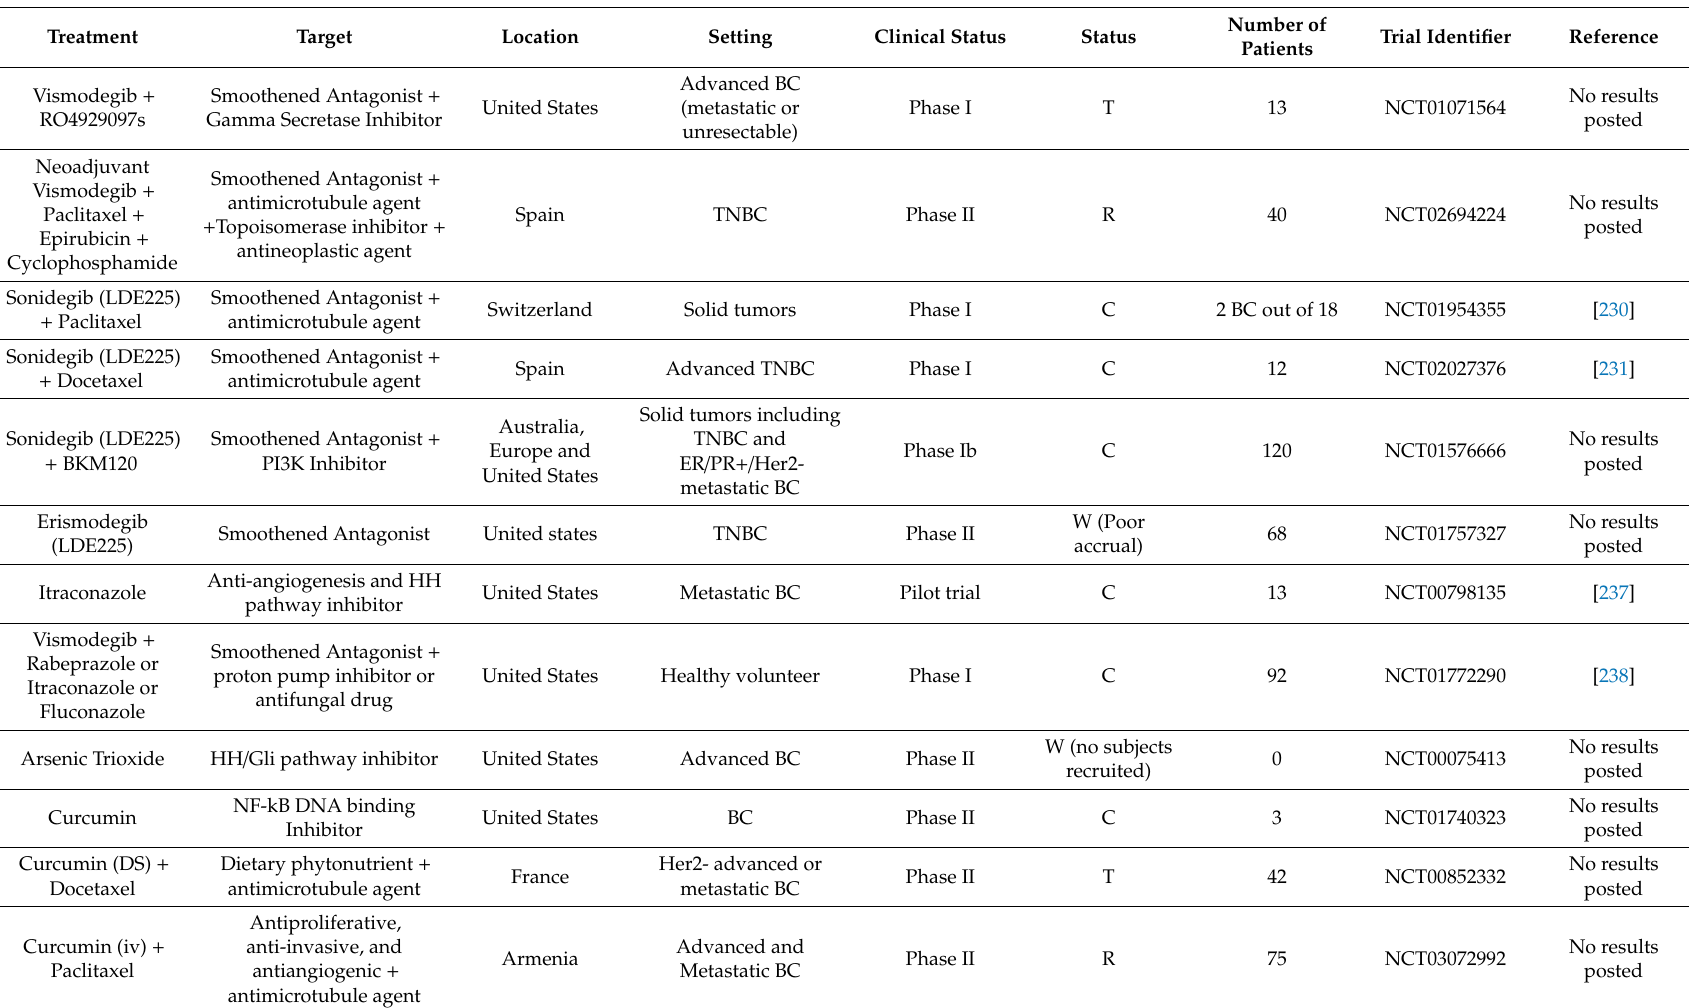
Table 3. Current clinical trials in breast cancer with drugs that target (directly or indirectly) the Hedgehog signaling pathway (Data from www.clinicaltrials.gov.).